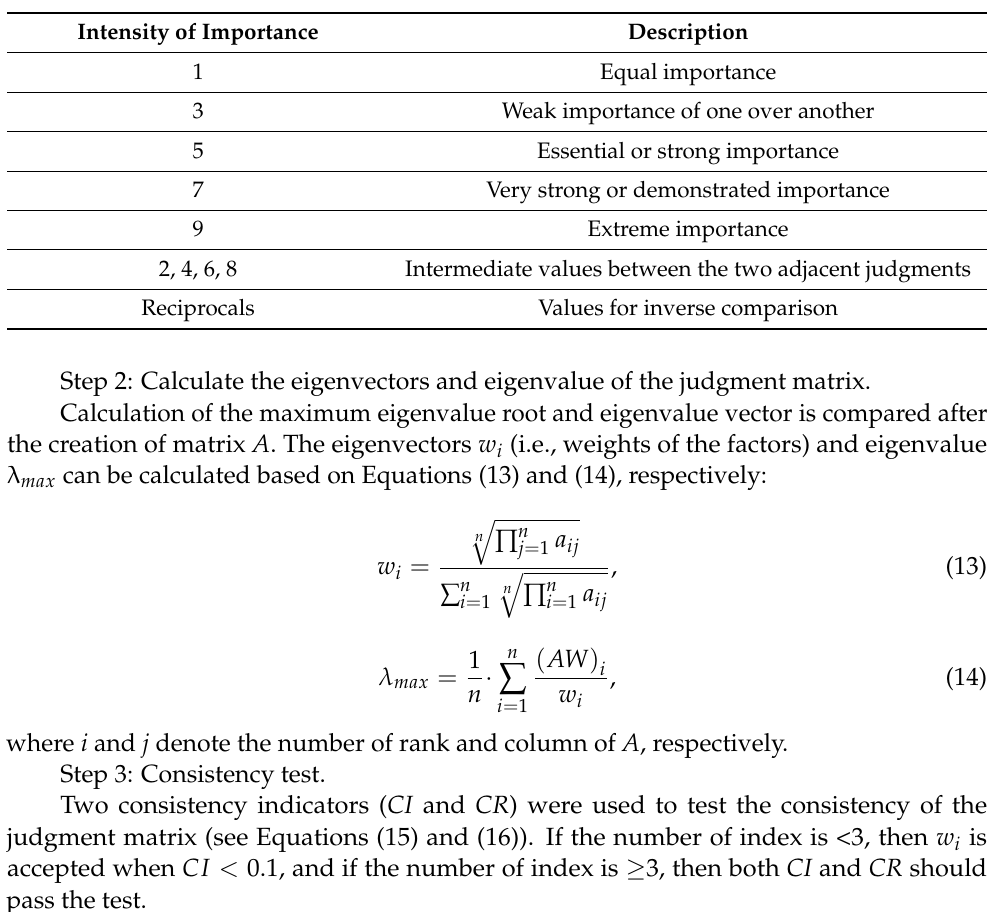
Table 3. Rating scales for pairwise AHP comparisons.